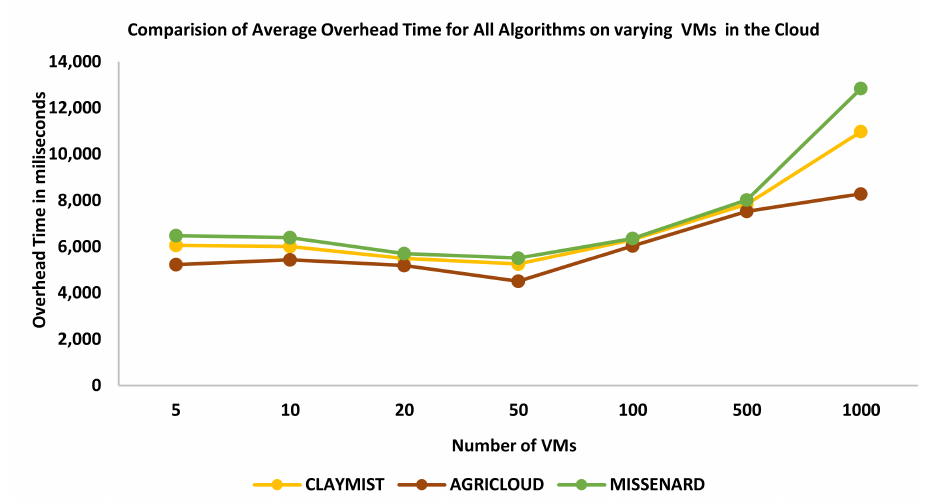
Figure 4. Overhead time of AGRICLOUD with